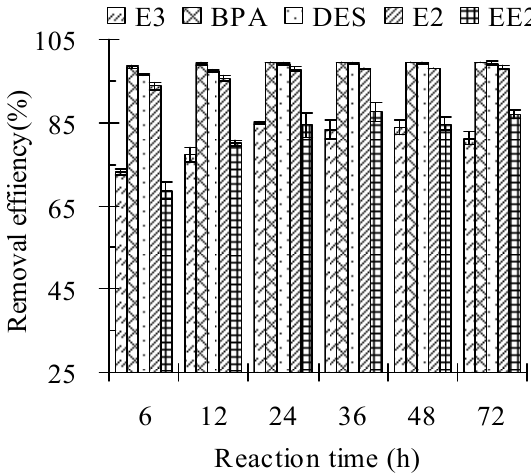
Figure 5. Effect of reaction time on the removal efficiency of estrogens from cow manure by the Fenton oxidation process. Note: the Fe(II) to H 2 O 2 molar ratio was 0.10 M/M; the H 2 O 2 dosage was 2.56 mmol/g; the solid to water mass ratio was 2 g/mL; the initial pH value was 3.0. Error bars represent standard deviations.